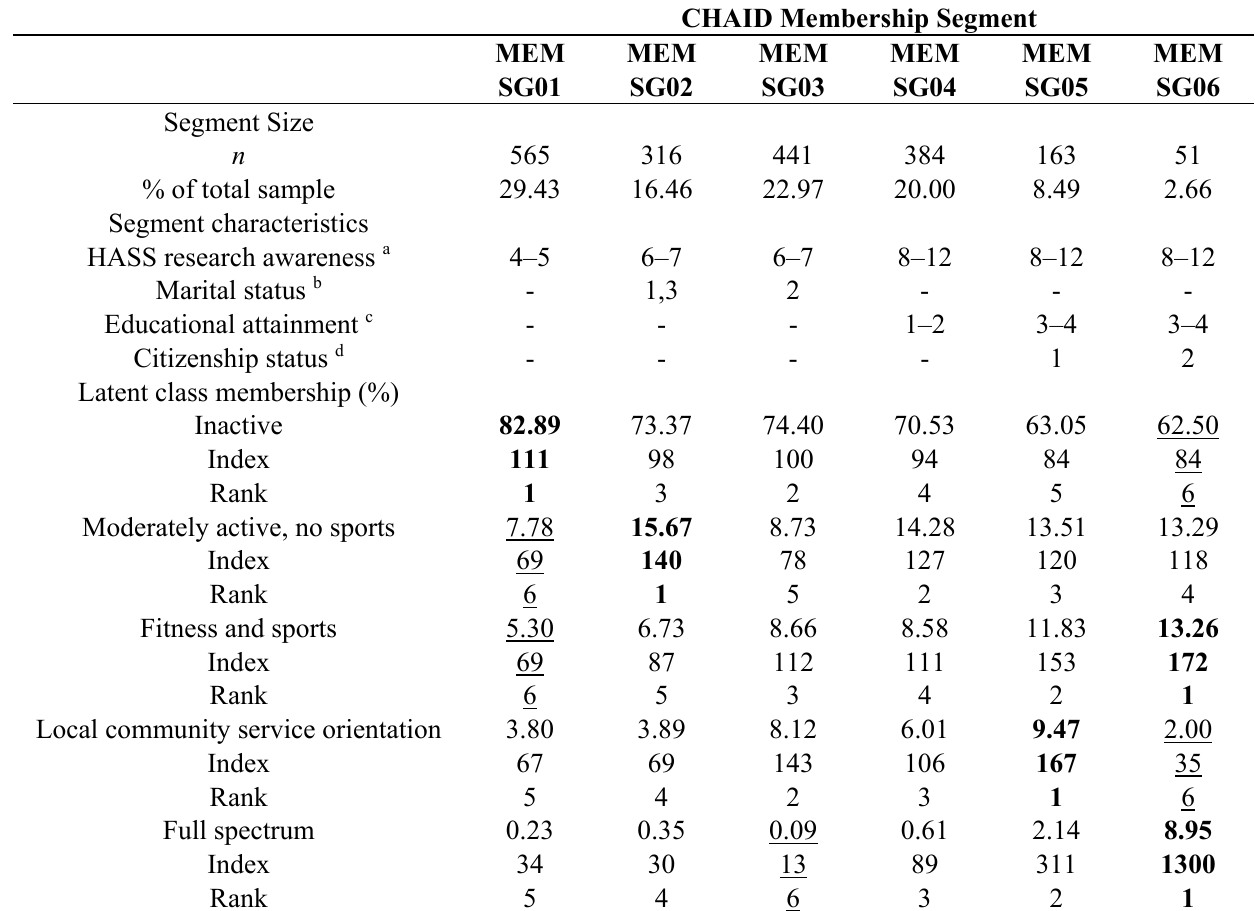
Figure 7. Membership-based sample segmentation (first level of the CHAID dendogram only; HASS research awareness: 4 = no awareness to 12 = highest awareness). Table 5. Summary of segmentation of membership-based latent class